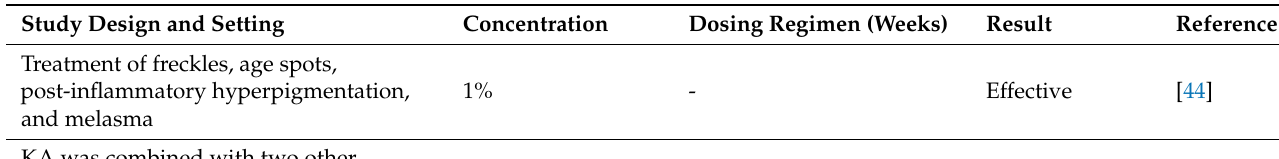
Table 3. Some of the findings of the clinical trials conducted on kojic